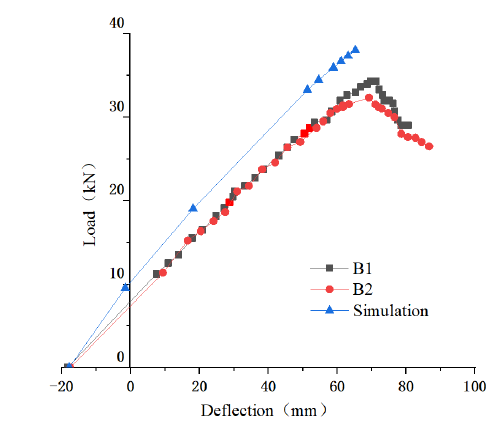
Figure 17. Load–deflection curves of tested beams and simulation.